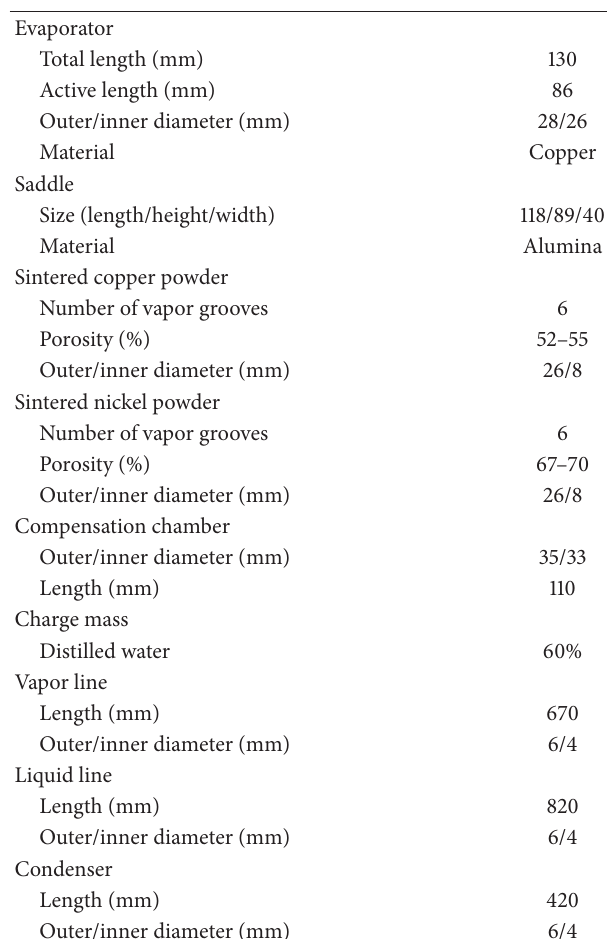
Table 5: Main design parameters of the